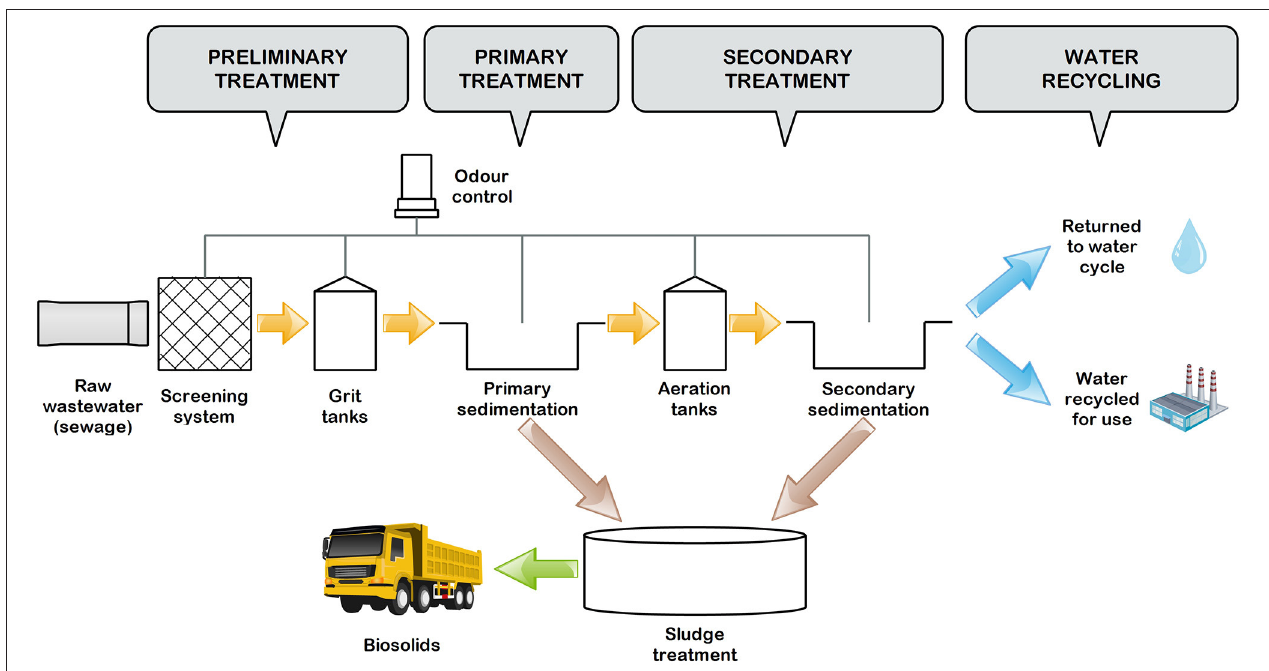
FIGURE 3 | Overall layout of a